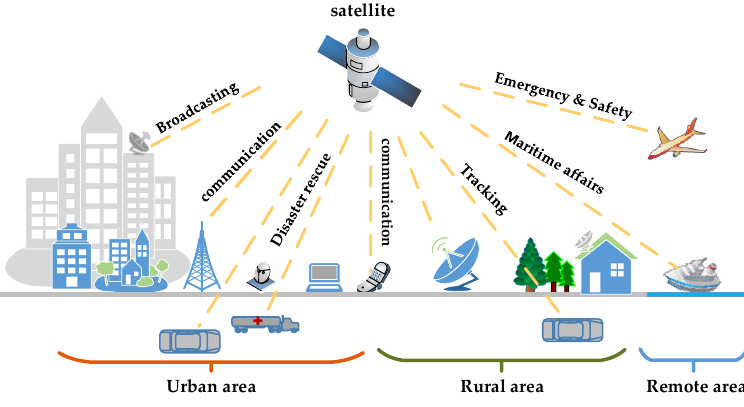
Figure 1. Wide application of satellite